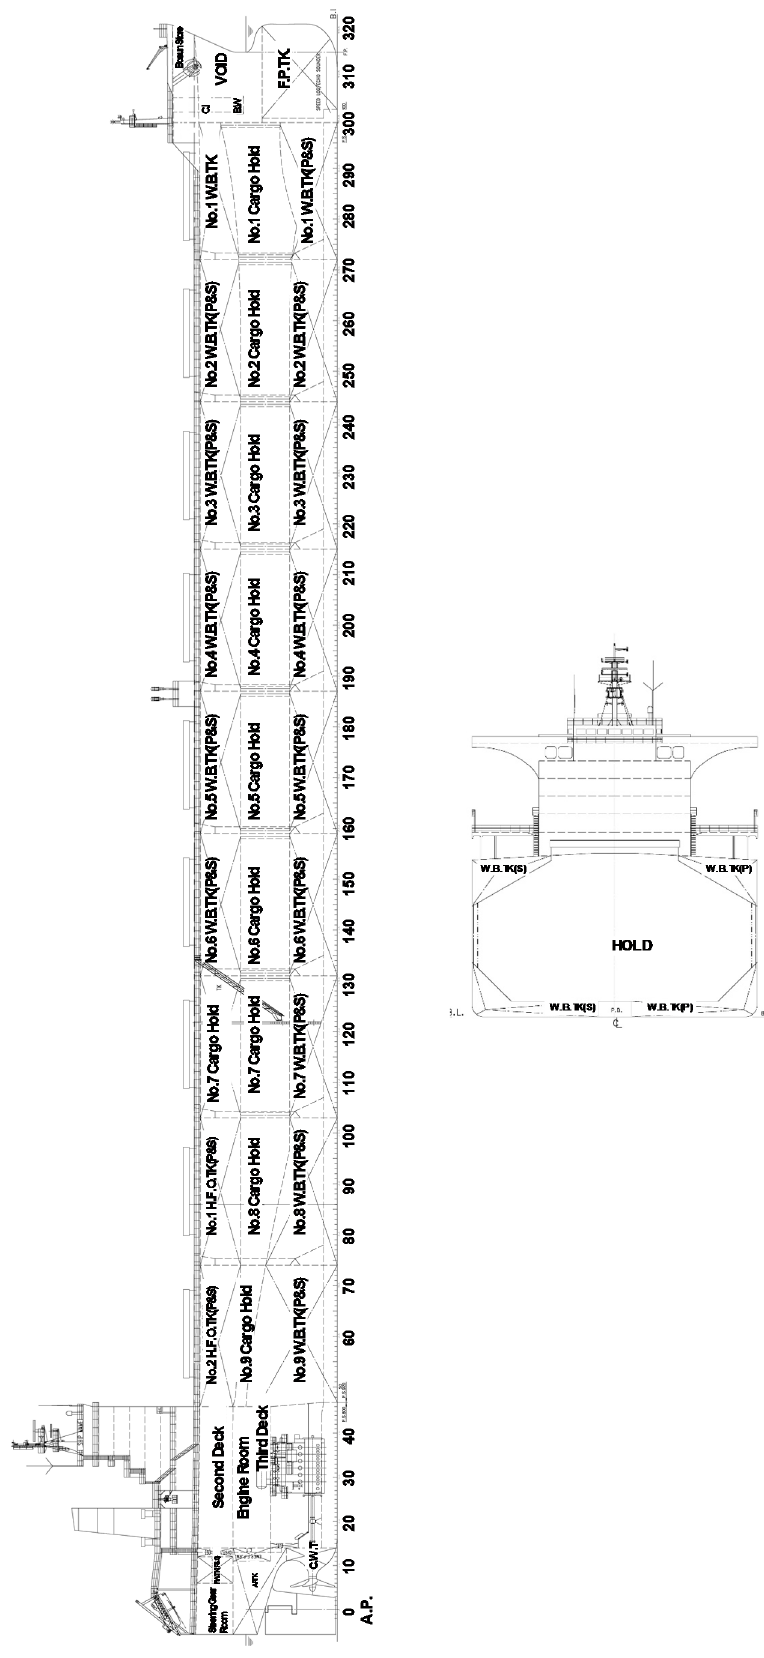
Figure 1. General arrangement of the vessel.